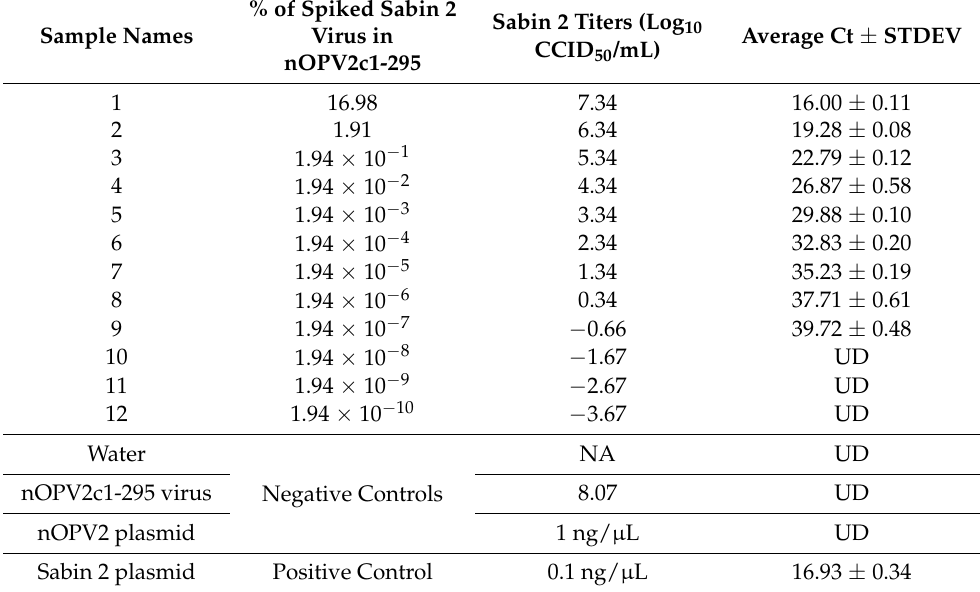
Table 3. Detection and quantification of Sabin 2 virus serially diluted in nOPV2c1-295.